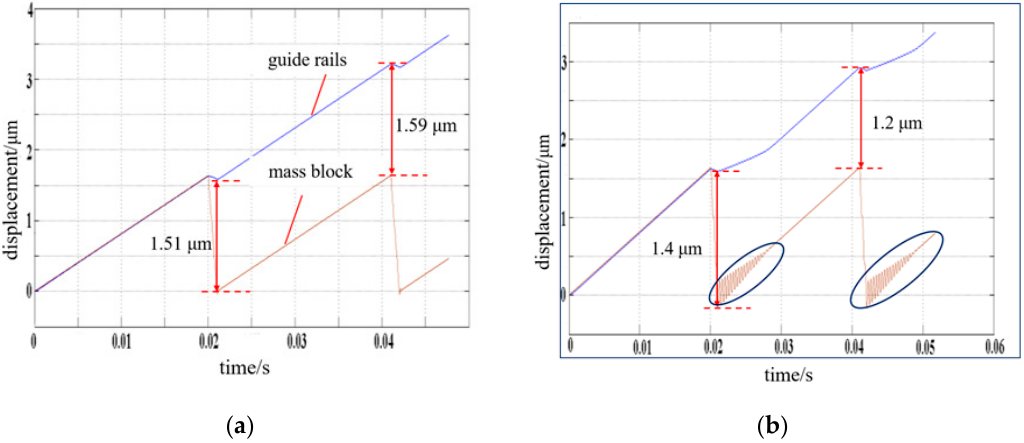
Figure 8. Simulation results of displacement under different total mass of adjusting unit and mass block: ( a ) total mass of 0.025 kg; ( b ) total mass of 0.25 kg.